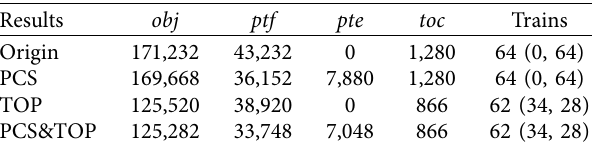
Figure 5: The results of 50 experiments with the same parameters. Table 4: Comparison of the objective function and each part in different results.